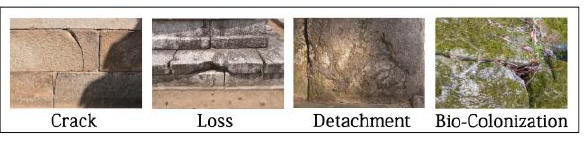
Figure 2. Damage type of dataset.